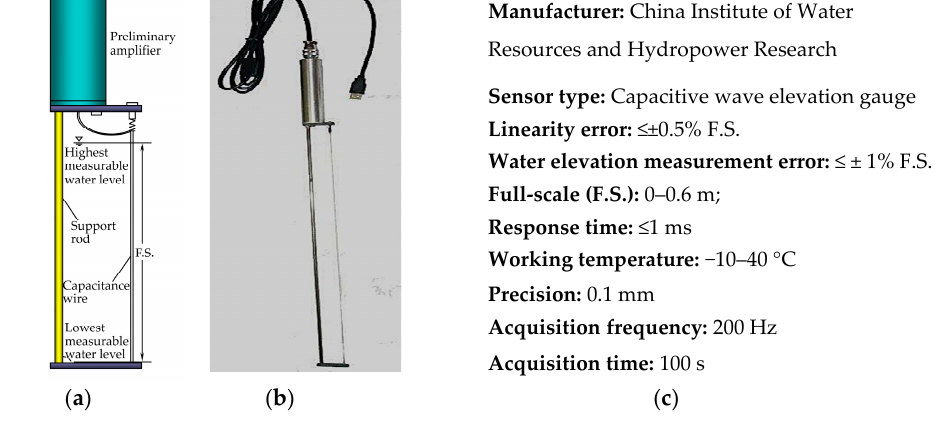
Figure 13. Constitution and performance parameters for the wave elevation gauge. ( a ) sensor components; ( b ) actual photograph; and ( c ) performance parameters.